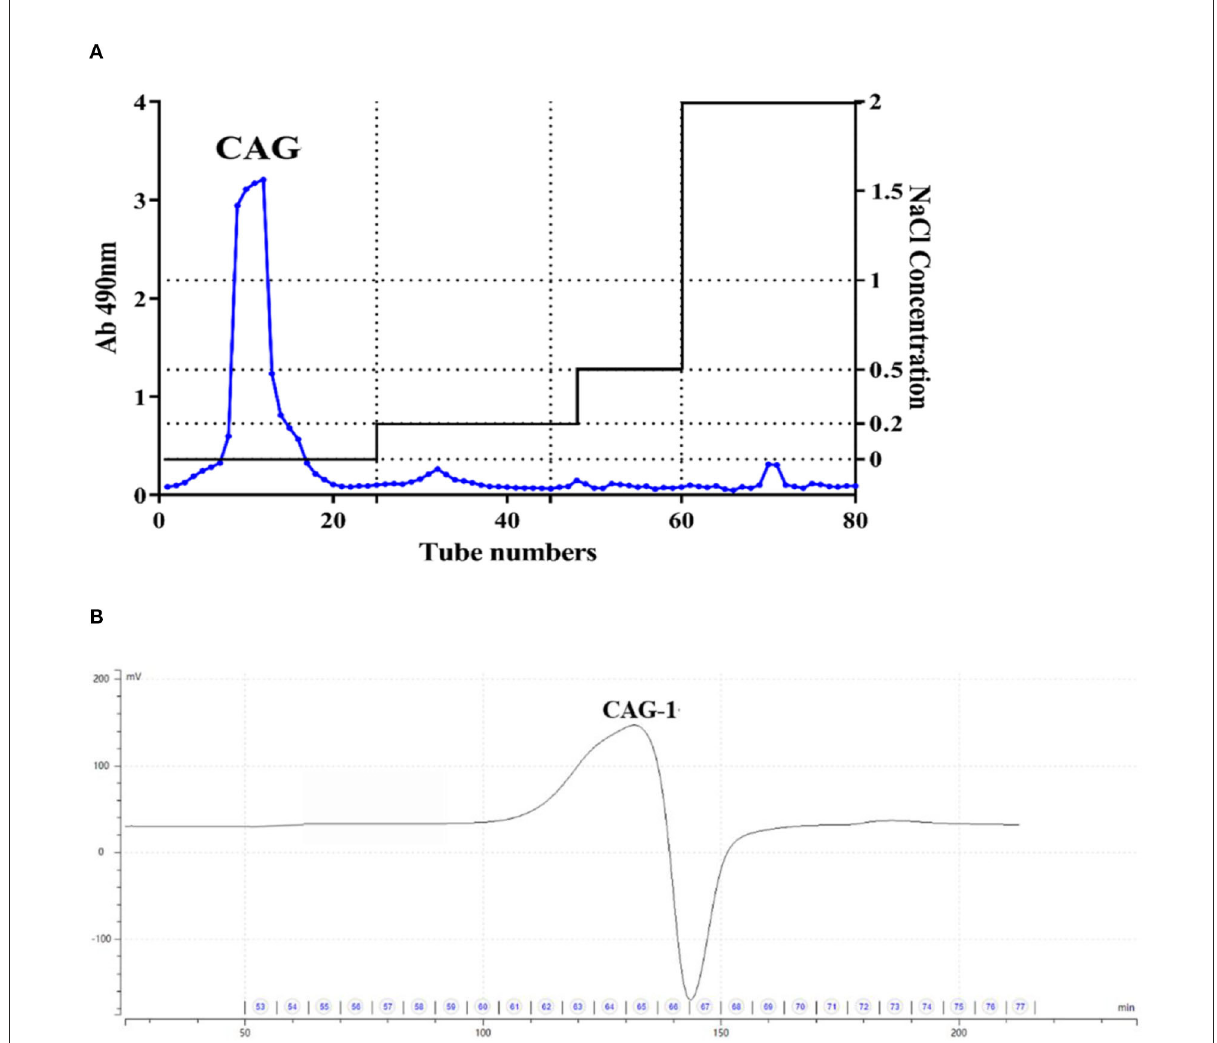
FIGURE1 Purification of chickpea glycoproteins. (A) Crude chickpea glycoprotein (CAG) was passed from the DEAE-Sepharose column; (B) A purified fraction from the Superdex-200 column.